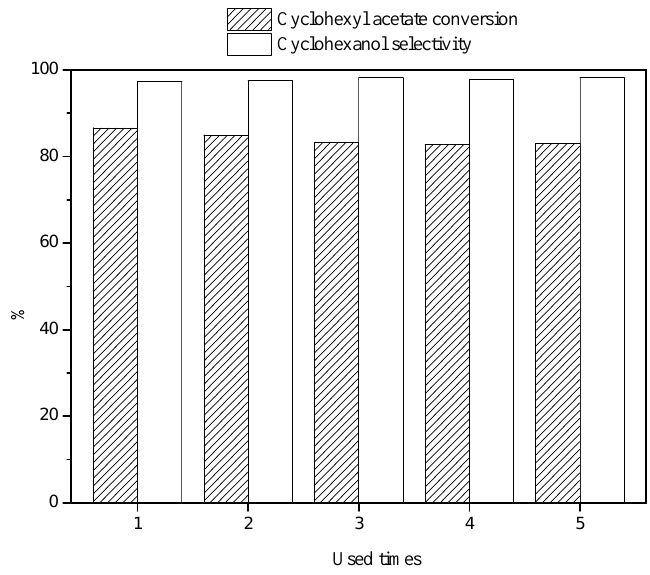
Figure 9. Reusability of CSALA for the hydrolysis of cyclohexyl acetate. Reaction conditions: cyclohexyl acetate 8 mL (55 mmol), H 2 O 40 mL (2222 mmol), CSALA 1.2 g, 130 °C, 3 h.